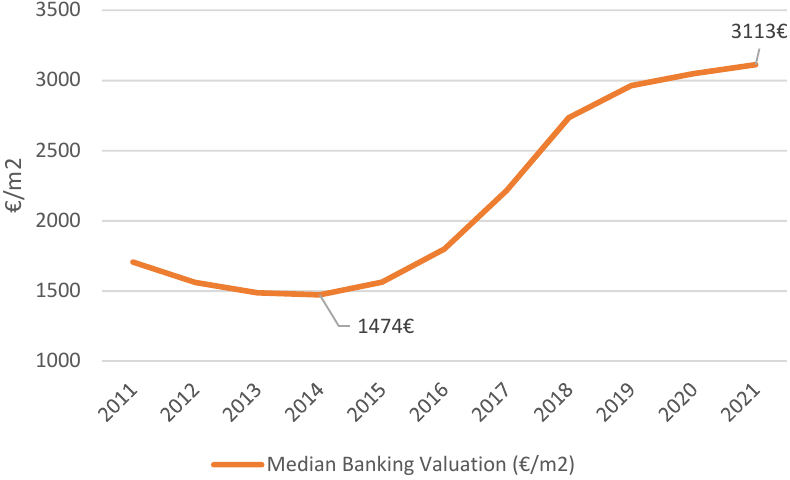
Figure 4. Median banking valuation ( € /m 2 ) of properties in Lisbon Municipality, from 2011 to 2021. Source: INE.